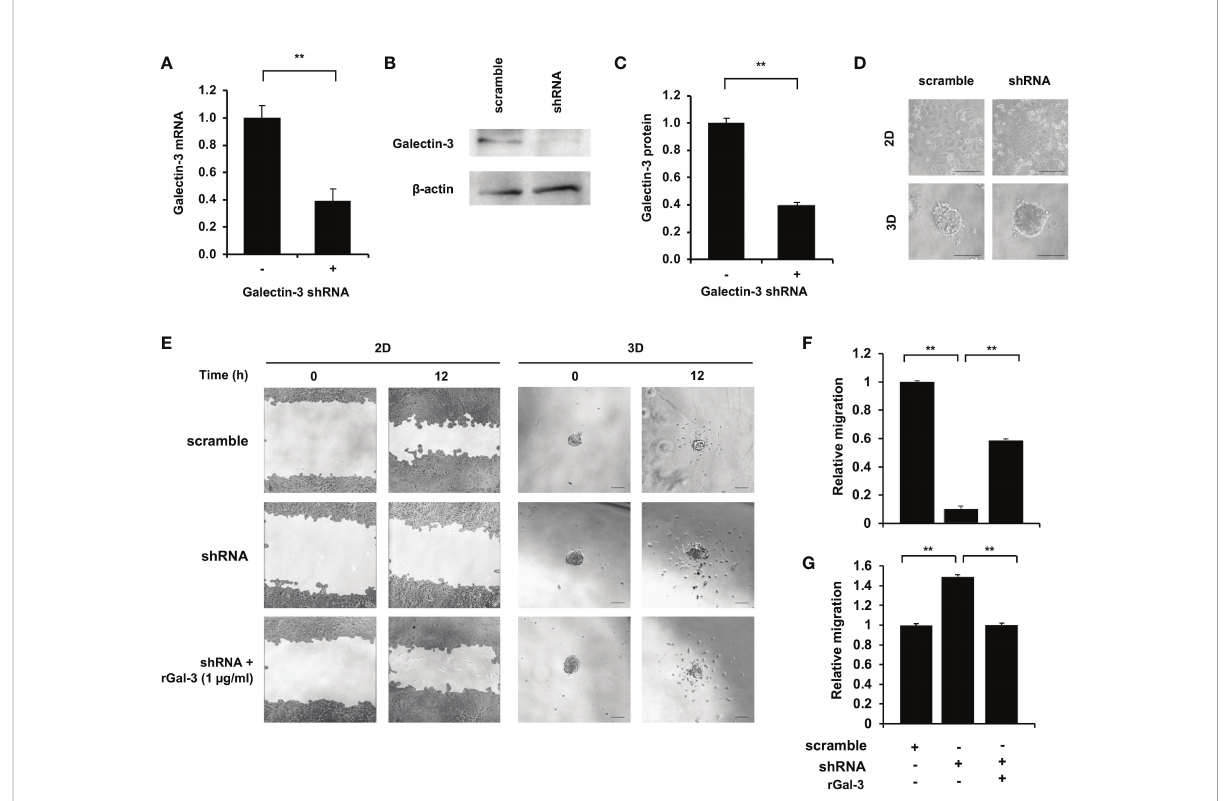
FIGURE 5 Effect of galectin-3 on 2D and 3D KKU-213A cell migration. (A) The relative galectin-3 mRNA level of KKU-213A knockdown cells compared to the control. (B) Representative galectin-3 immunoblots of KKU-213A cells subjected to gal-3 and scrambled shRNA. b -actin was used as the loading control. (C) The relative galectin-3 protein expression of KKU-213A knockdown cells compared to the control. (D) The morphology of galectin-3 knockdown cells in 2D and 3D cultures. The 2D culture images were taken before cells reached con fl uence and 3D culture images were taken on day 6. (E) Control and galectin-3 knockdown KKU-213A cells were grown as monolayer or tumor spheroids for 4 days. rGal-3 was treated during the migration assay. The migration area of KKU-213A monolayer and tumor spheroids were collected at 0 h and 12 h. The scale bars represent 100 µm. (F, G) Bars represent the relative migration of galectin-3 knockdown cells with and without the treatment of rGal-3 in (F) 2D and (G) 3D conditions compared to the control cells. The data represent means and ± standard error. ** p <